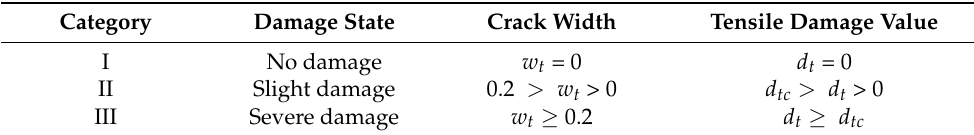
Table 3. Material parameters of the surrounding rock and concrete